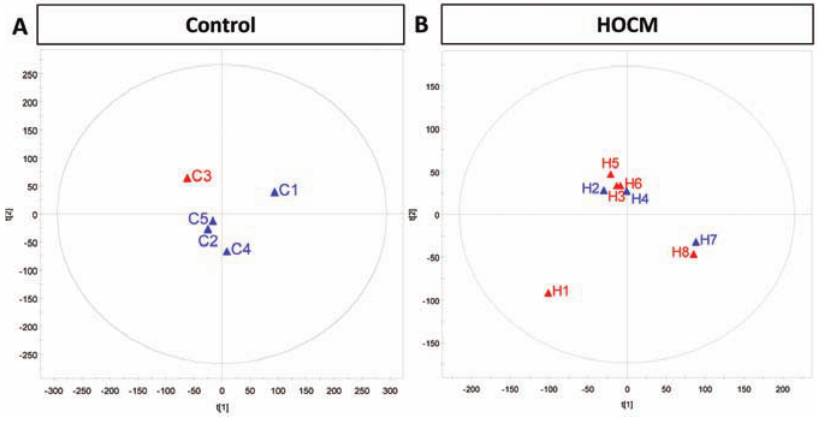
2. The PCA analysis revealed no groupings in the control group (A, control patient history can be found in Table 4) and three clusters in the hypertrophic obstructive car- diomyopathy (HOCM) patient group (B, HOCM patient history can be found in Table 2 and 3). Females are shown in red and males in